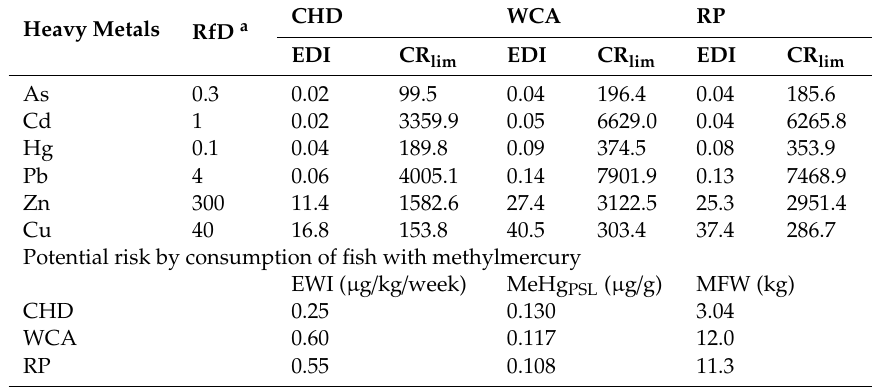
Table 2. Estimates of the potential risk in the di ff erent age groups.